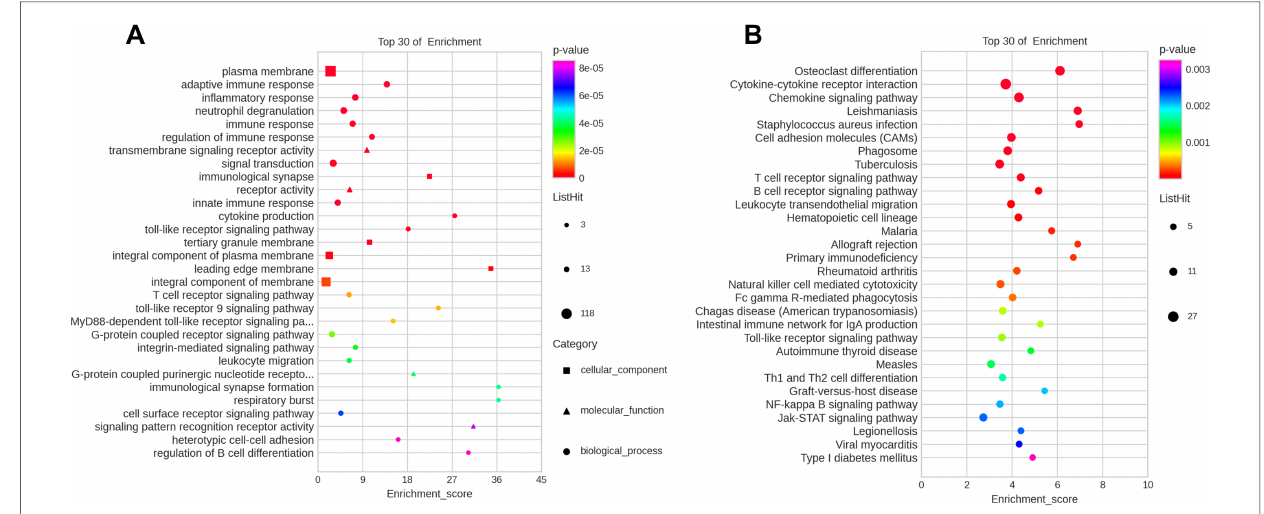
FIGURE 6 Top 30 most enriched GO and KEGG terms by coexpression target mRNAs. ( A ) Top 30 enriched terms according to GO analysis. ( B ) Top 30 signaling pathways according to KEGG